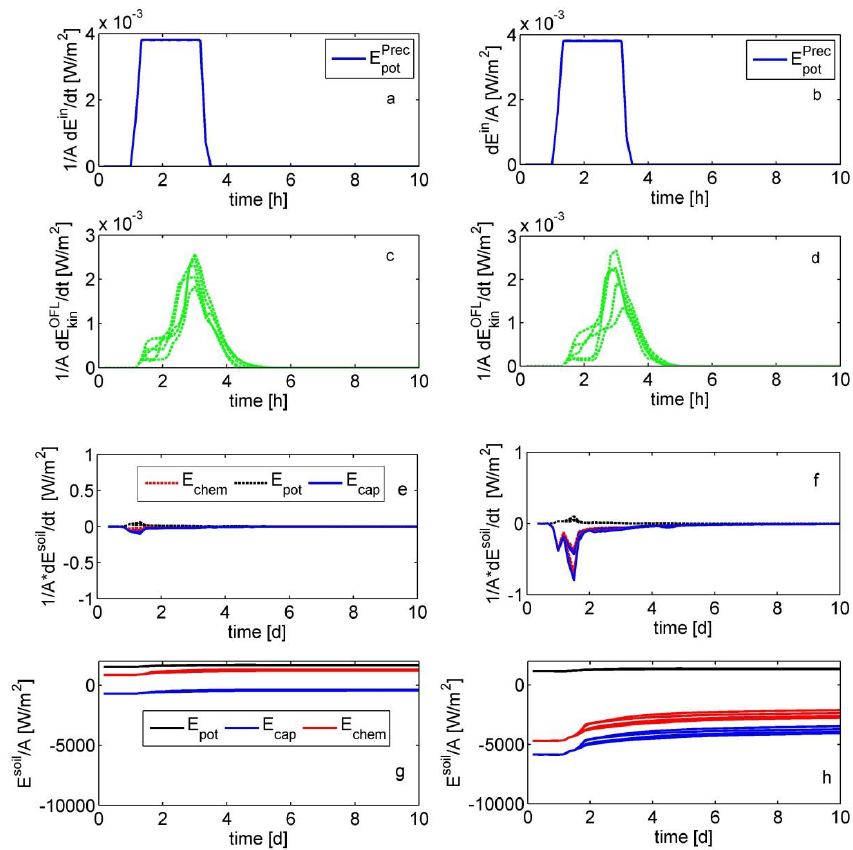
Fig. 5. Free energy balance components of numerical experiment 1. Time series of potential energy input by rainfall (panels a and b), kinetic energy export by surface runoff (panels c and d), temporally averaged change rates in potential energy, the absolute value of capillary binding energy and free energy of soil water (panels e and f, compare Eq. 7) and the time series of free energy components of soil water (panels g and f, after Eq. 2). The left panels a, c, e, and g belong to the wet initial saturation of S = 0.8, the right panels to the dryer initial saturation of 0.6. Please note that kinetic energy export by surface runoff deceases with macropore density, while changes in capillary binding energy increase with macropore density.